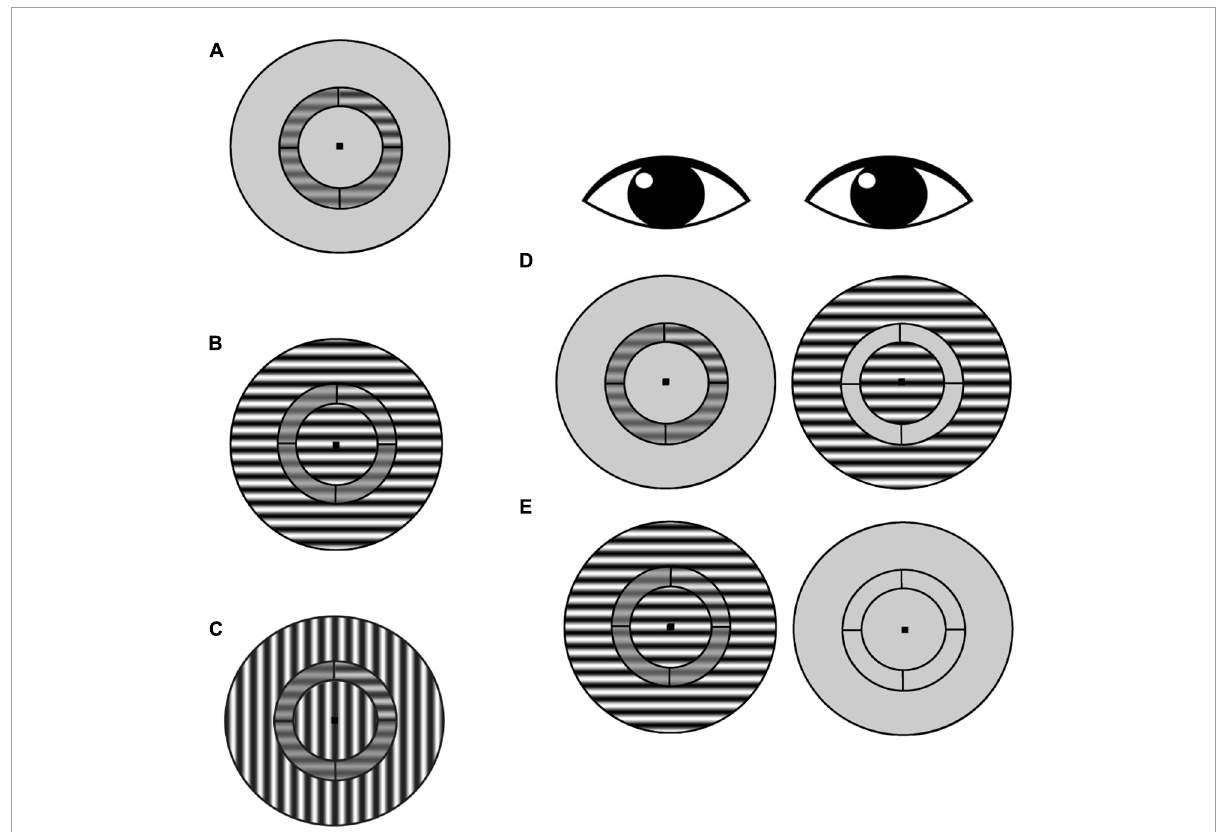
FIGURE2 Surround suppression task. (A) Subjects were asked to identify which annulus quadrant contained a contrast increment relative to the pedestal contrast (in this example, the target contrast increment is in the upper right quadrant). This no-surround condition was used to estimate baseline contrast discrimination thresholds for each participant. (B) Iso-oriented condition: target-containing annulus and surround share the same orientation. (C) Cross-oriented condition: annulus and surround have orthogonal orientations. (D) Schematic of dichoptic presentation. The annulus was presented to one eye, and the surround was presented to the other eye. In this example, the surround is iso-oriented [as in (B )], but cross-oriented surrounds [as in (C) ] were also tested. (E) Schematic of monocular presentation, with annulus and surround presented to one eye and only the fixation point presented to the other eye.